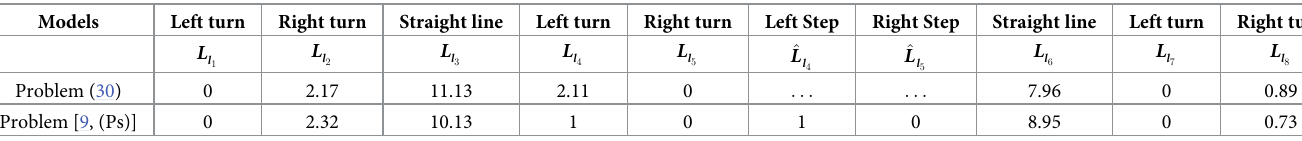
Table 3. Numerical performance of model (30) and [9, Section 5.1, Problem (Ps)].